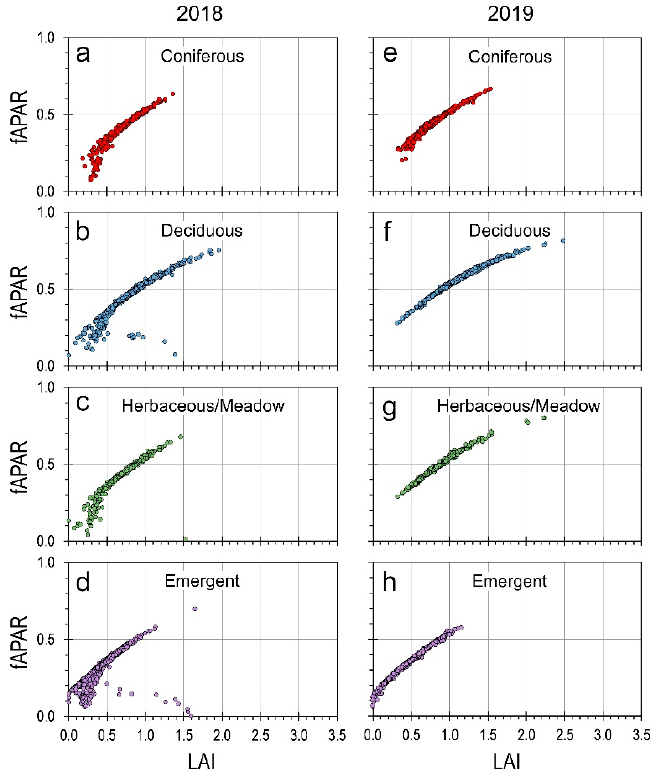
Figure 16. September comparison of fAPAR vs. LAI for the 2018 ( a – d ) and 2019 ( e – h ) for the Coniferous, Deciduous, Herbaceous/Meadow and Emergent classes. See Figure 13 for definition of acro- nyms.